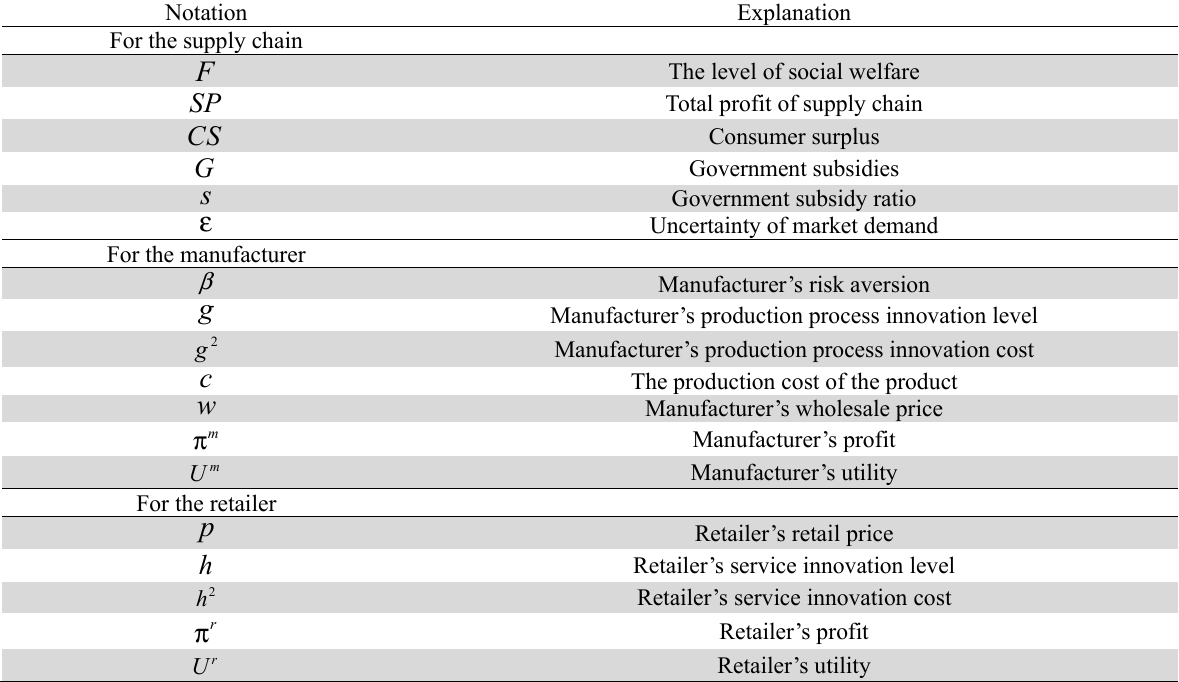
Major notation and